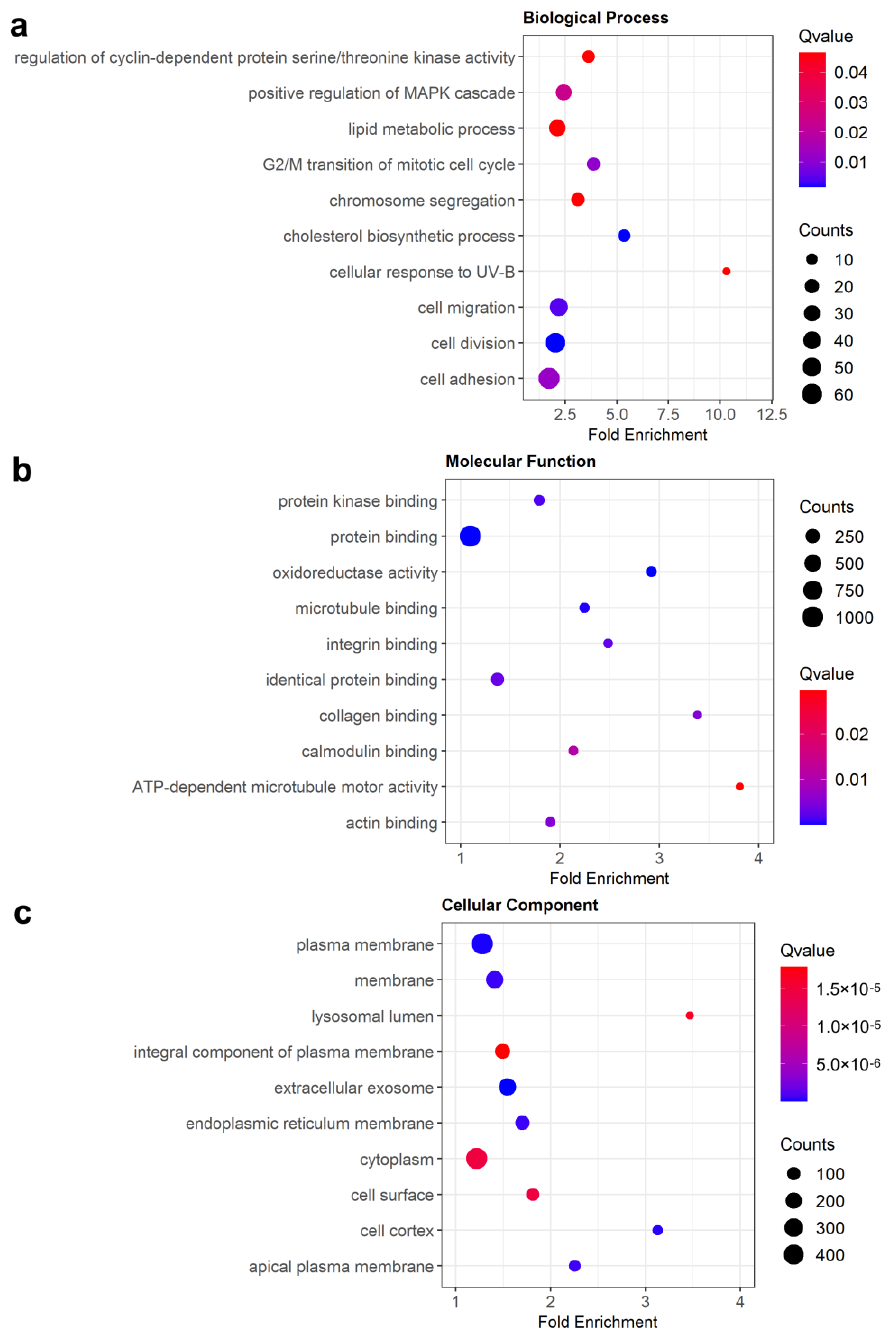
Figure 3. Bubble plots for GO analysis of upregulated DEGs. The top 10 enrichment terms from the GO analyses are plotted for ( a ) biological process, ( b ) molecular function, and ( c ) cellular compo- nent.